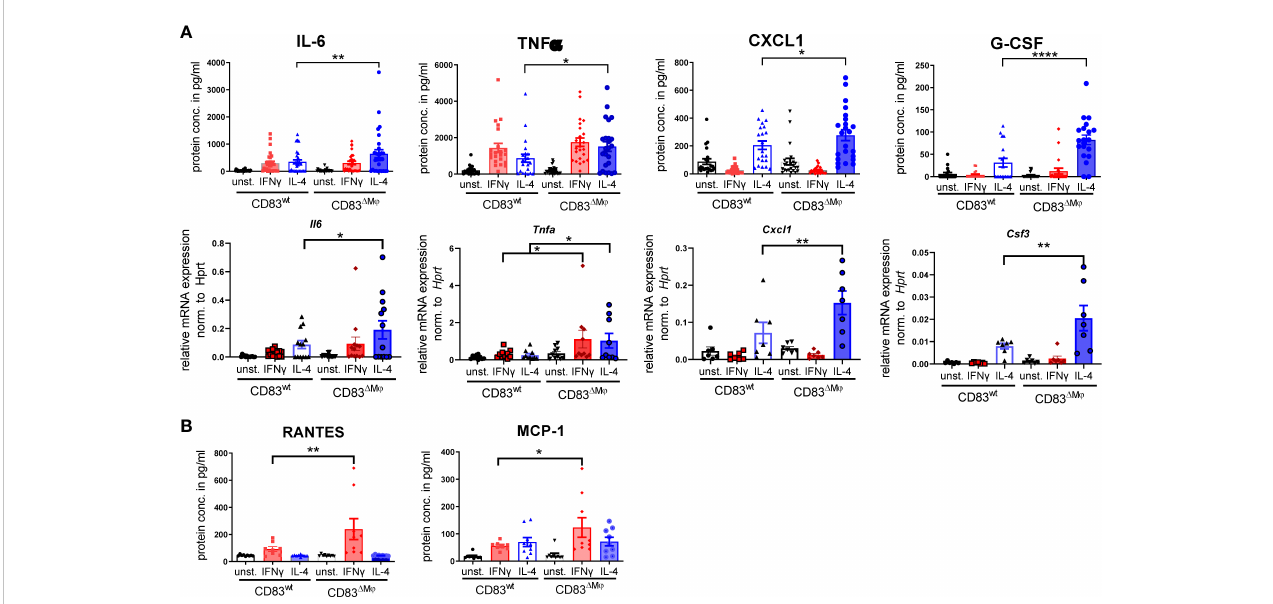
FIGURE 5 CD83-de fi cient IL-4- as well as IFN- g -stimulated M j show a pro-in fl ammatory pro fi le. Bone-marrow derived M j were generated and differentiated either into CAM or AAM, via IFN- g or IL-4 respectively, or were left untreated for 16h. Afterwards, the supernatants were analyzed by CBA and cells via qPCR. (A) IL-4 stimulated CD83-de fi cient M j show increased secretion levels of IL-6, TNF- a , CXCL1 and G-CSF (upper bar graphs). qPCR analyses showed signi fi cantly increased mRNA levels of Il-6, Tnfa, Cxcl1 and Csf3 in IL-4-stimulated CD83 KO M j (lower bar graphs). (B) CCL5/RANTES and MCP- 1 expression levels are increased in supernatants of IFN- g -stimulated CD83-de fi cient M j . Statistical analyses were performed by One-way ANOVA or the appropriate corresponding non-parametric test. Data are represented as mean ± SEM. Experiments were performed at least three times. *p< 0.05; **p<0.01; **** p< 0.0001. The absence of asterisks indicates that there is no statistical signi fi